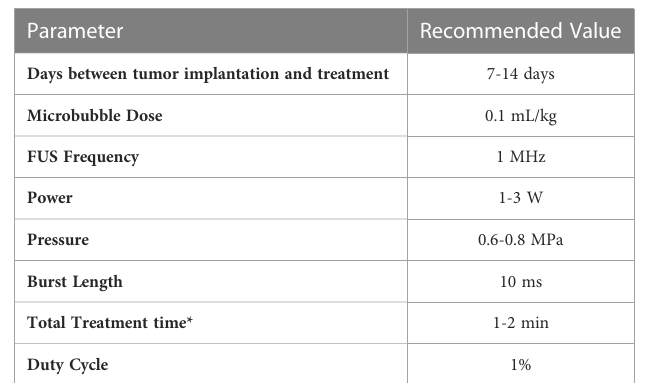
TABLE 3 Most Commonly Used Parameters for BBB Openings. *Per Sonication